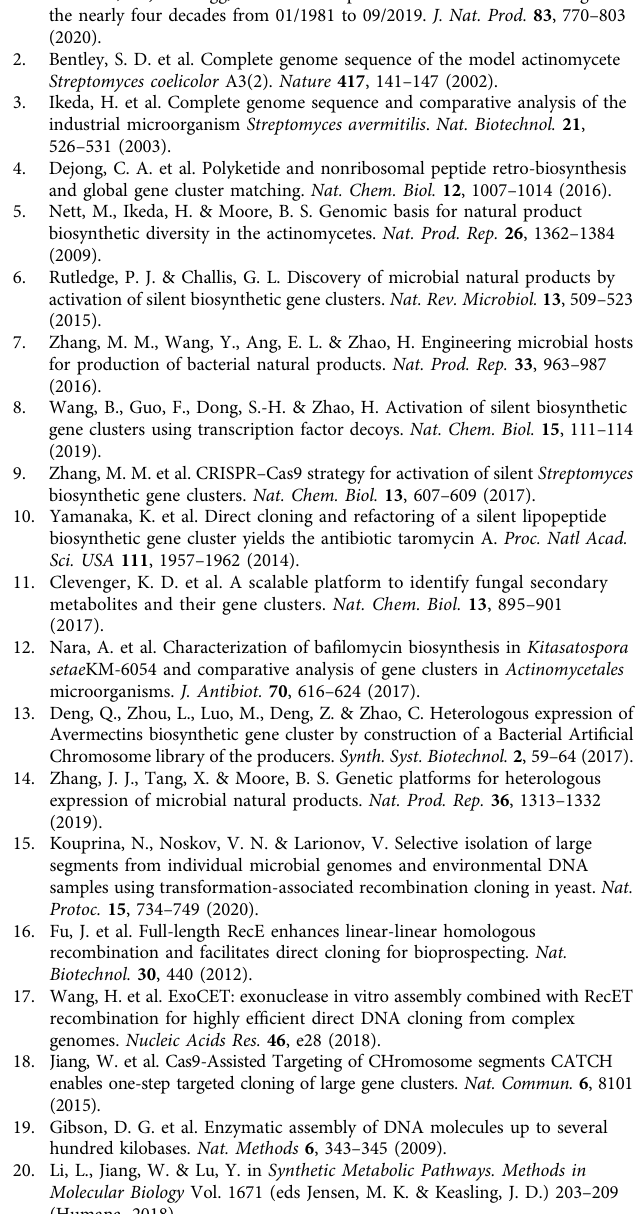
Table 2; HRMS ( m / z ): (ESI/[M – H] − ) calcd. for C 41 H 21 O 12 , 705.1038; found, 705.1049. Bipentaromycin C ( 3 ). Red powder; 1 H and 13 C NMR: see Supplementary Table 3; HRMS ( m / z ): (ESI/[M – H] − ) calcd. for C 43 H 25 O 13 , 749.1301; found, 749.1320. Bipentaromycin D ( 4 ). Red powder; 1 H and 13 C NMR: see Supplementary Table 3; HRMS ( m / z ): (ESI/[M – H] − ) calcd. for C 43 H 23 O 13 , 747.1144; found, 747.1145. Bipentaromycin E ( 5 ). Red crystal; 1 H and 13 C NMR: see Supplementary Table 4; HRMS ( m / z ): (ESI/[M – H] − ) calcd. for C 45 H 29 O 13 , 777.1614; found, 777.1619. Bipentaromycin F ( 6 ). Red powder; 1 H and 13 C NMR: see Supplementary Table 4; HRMS ( m / z ): (ESI/[M – H] − ) calcd. for C 45 H 27 O 13 , 775.1457; found,